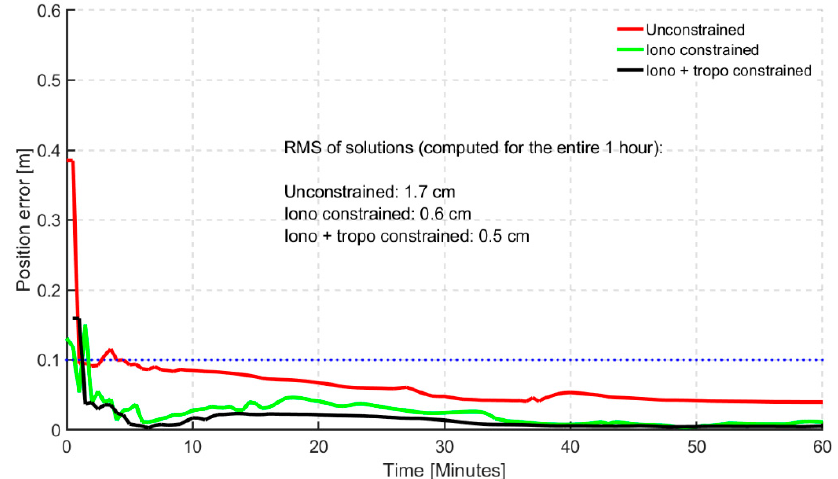
Figure 10. Histogram showing percentage of 40 stations converging based on 24 hourly solutions in dual-frequency GREC with GPS-AR processing mode. Results shown have a 20 cm horizontal error threshold.